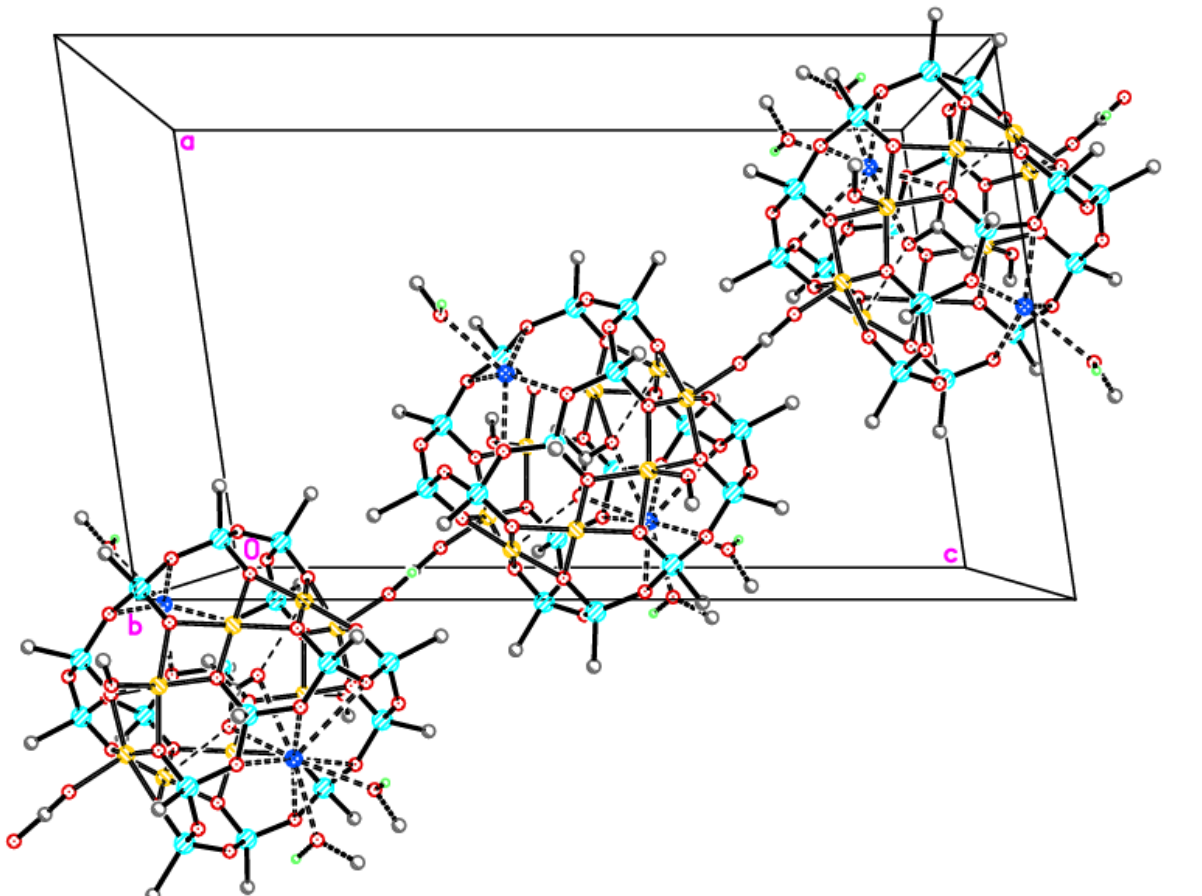
Figure 4. 1D coordination polymer structure in structure of 2 ; linked via formate bridges.